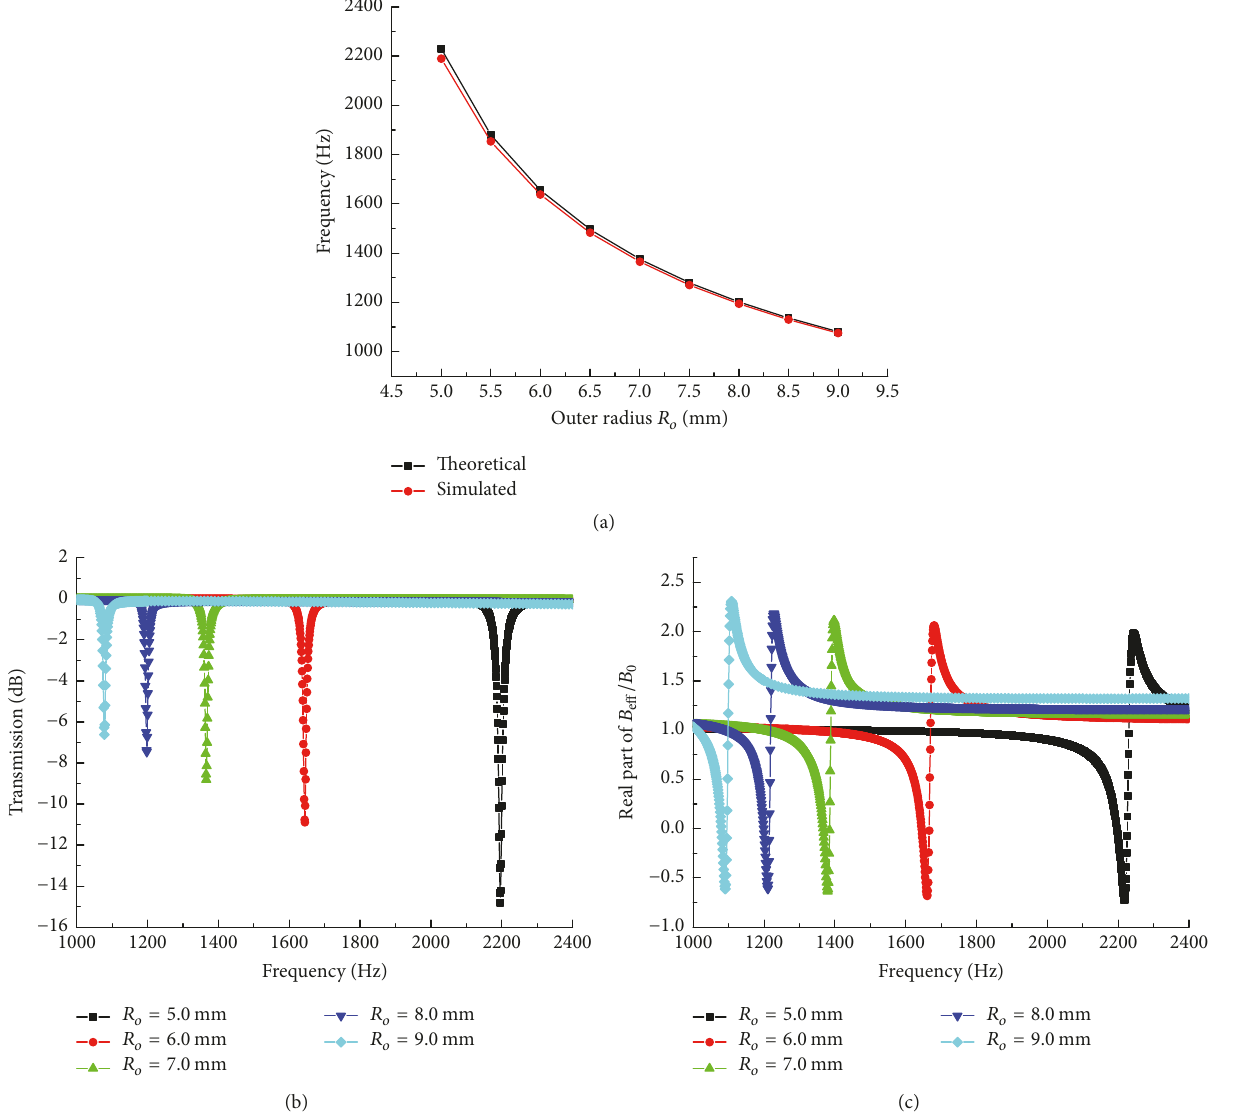
Figure 8: The relation curves present the relationship between the outer radius and related parameters ( 𝑅 𝑖 = 4.5 mm, 𝑎 = 0.5 mm). (a) The resonance frequency of SHS. (b) The transmission coefficient. (c) The effective